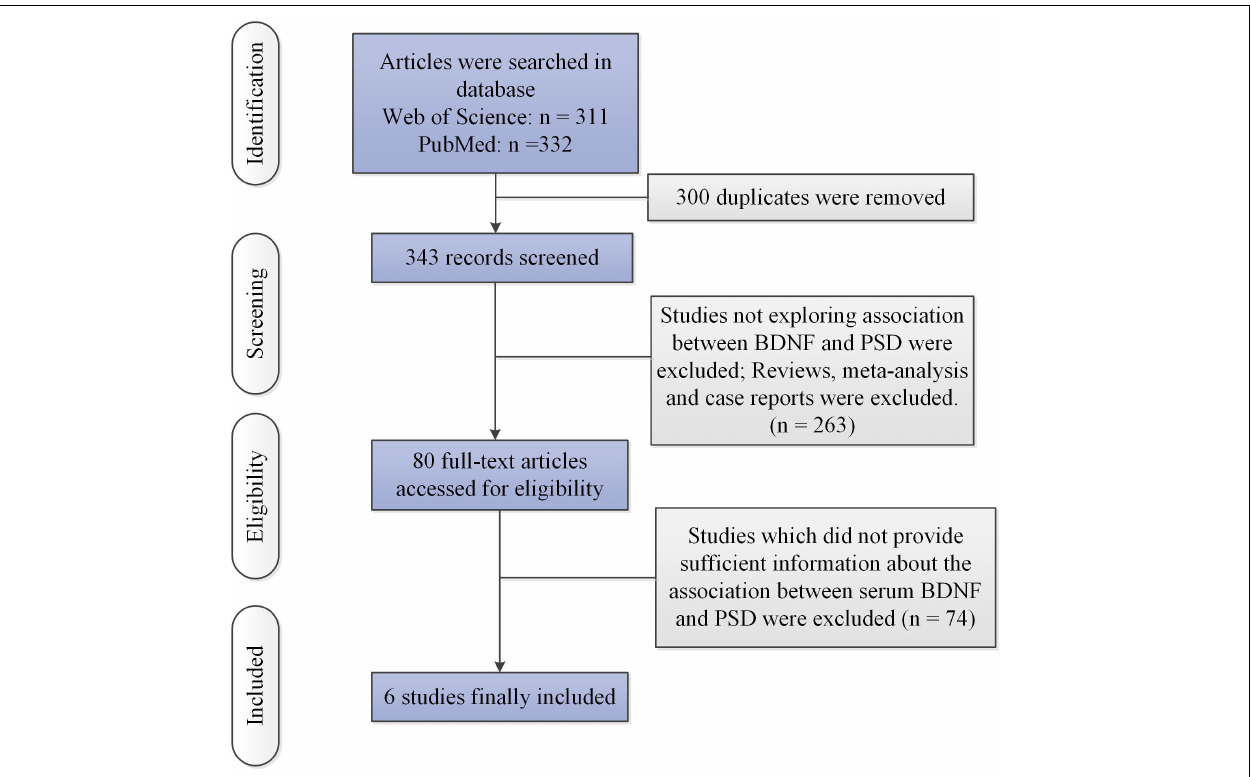
FIGURE 1 | The flow of information through the different phases of a